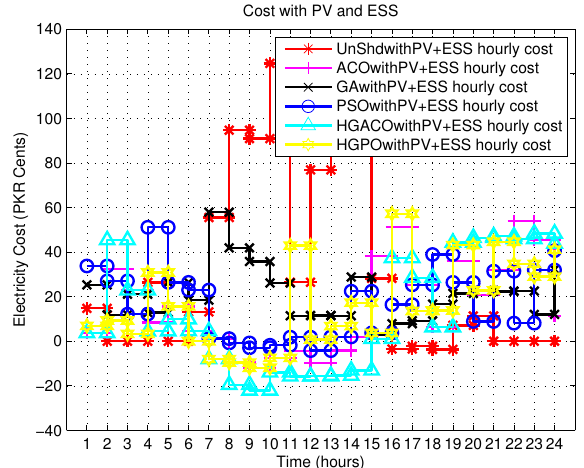
Figure 17. Scenario III: electricity cost assessment with photovoltaic-battery systems.